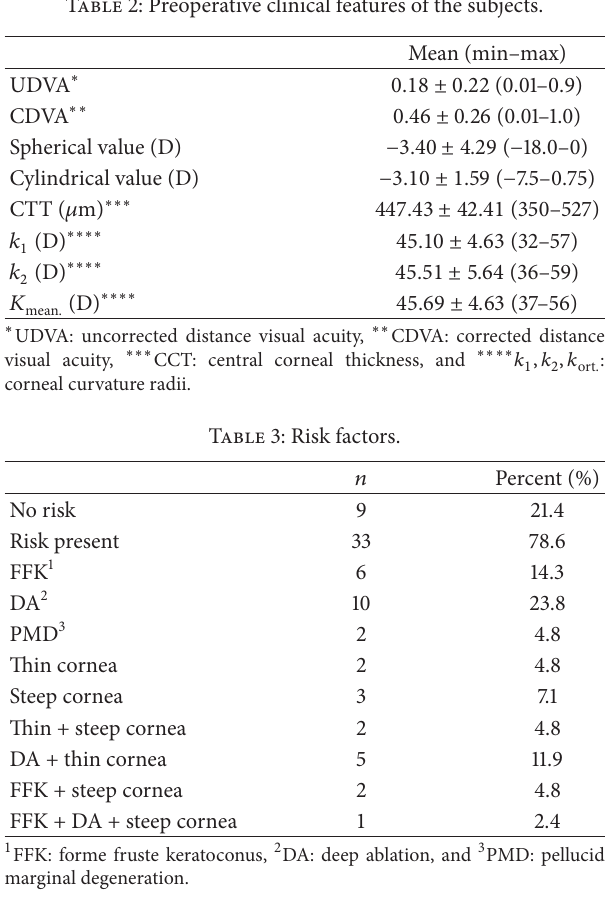
Table 2: Preoperative clinical features of the subjects.